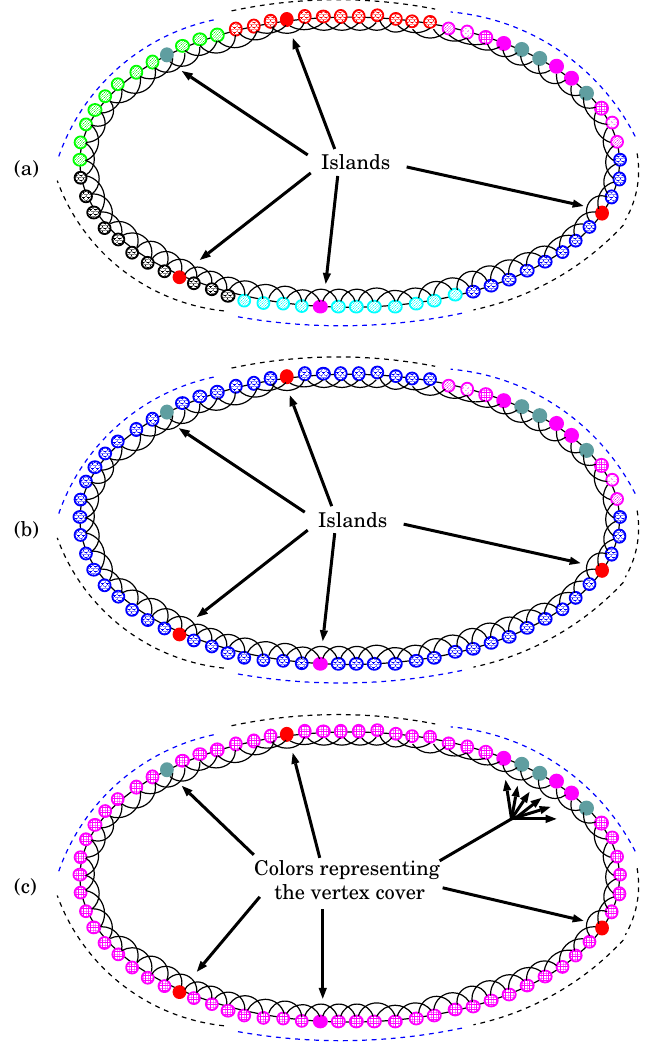
Fig. 8: States of the graph in Figure 5( c ) during an optimal